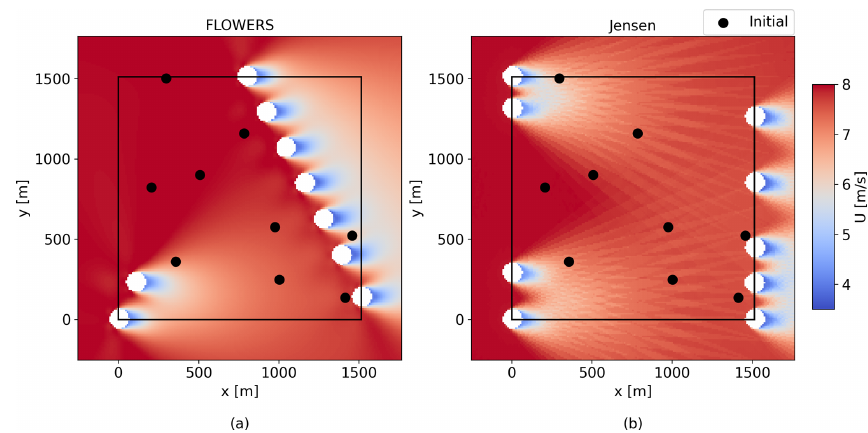
Figure 9. The optimal layouts for the FLOWERS and Jensen optimizers ( B = 72). The FLOWERS solution required 31.9s and achieved an AEP gain of 14.3%. The Jensen solution required 851s and achieved 12.9% AEP gain. The black dots denote the initial layout.